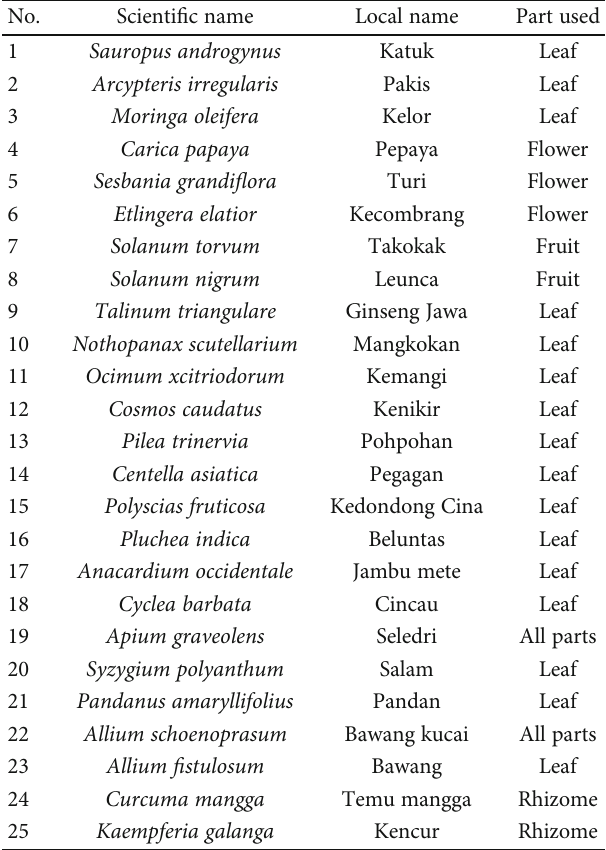
Table 1: Names and part of 25 select vegetables, herbs, and spices